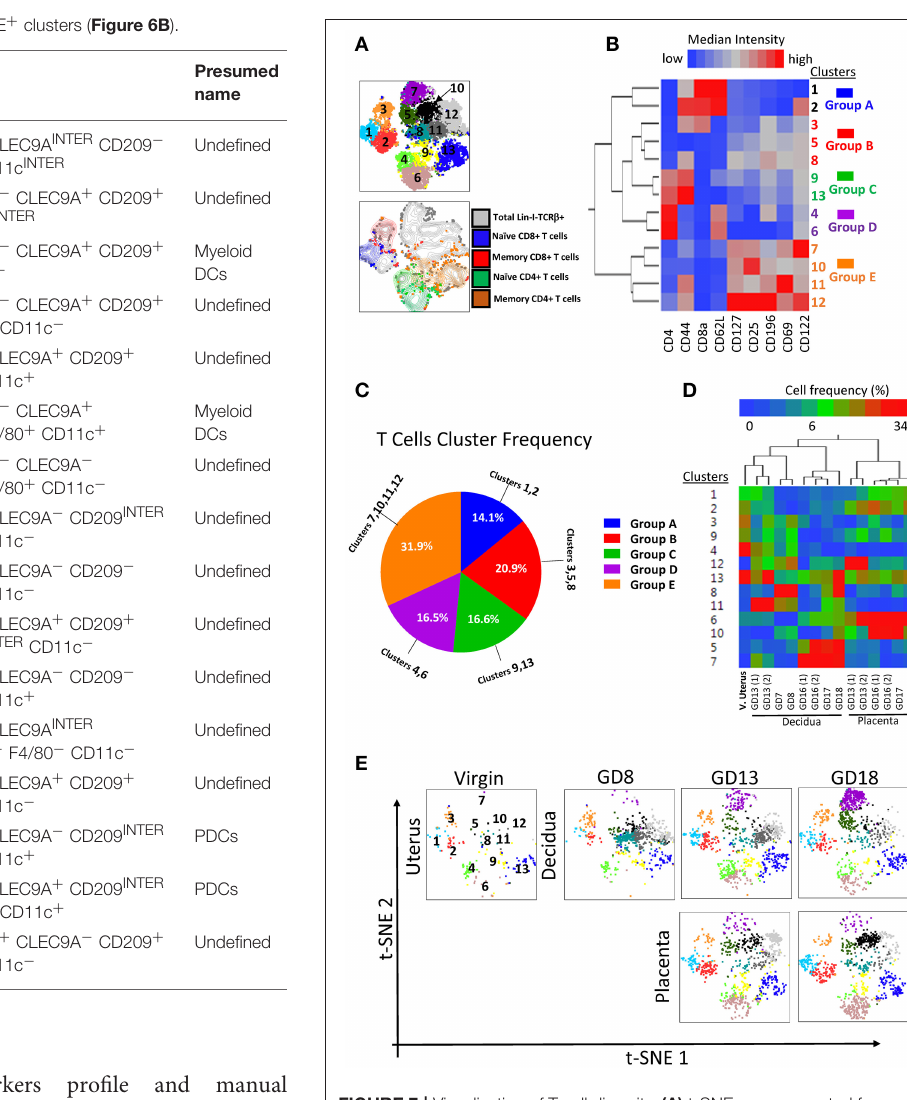
FIGURE 7 | Visualization of T cell diversity. (A) t-SNE map generated from pre-gated lin2-TCR β + cells from murine virgin uterus, decidua and placenta across gestational age data sets (top) and manually gated subsets overlaid onto total lin2-TCR β + cells (bottom). (B) Hierarchical clustering of median surface marker expression levels of clusters identified by DensVM. Total 13 clusters were categorized in 5 groups, group A–E (C) Pie chart of different group proportions of total DC population. (D) Hierarchical clustering of cluster frequency within lin2-TCR β + from murine virgin uterus, decidua and placenta across gestational age. (E) Separate visualization of cluster in different murine tissues across gestation using t-SNE map generated from the merged data